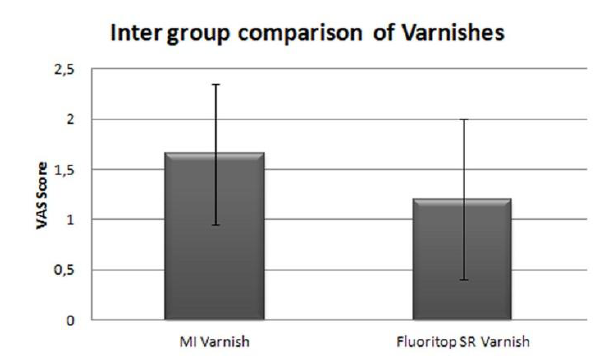
Figure 3 : Intergroup comparison of MI varnish® and Fluoritrop SR®. VAS Score is expressed as mean±SD. *p <